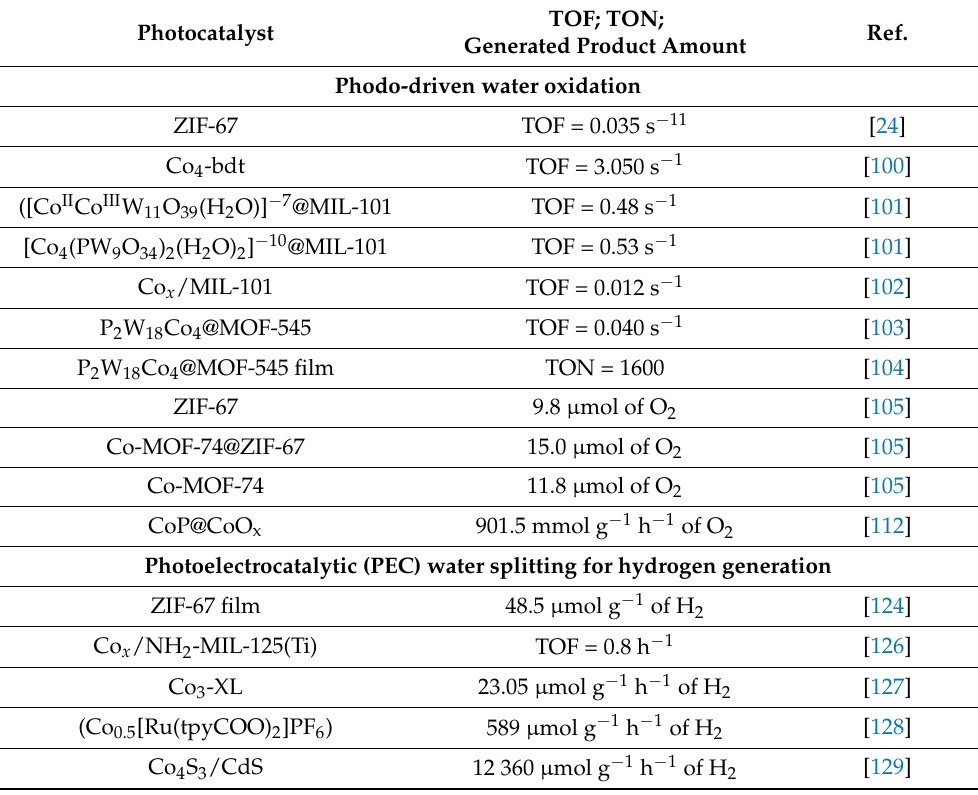
Table 2. Examples of Co-based MOFs, MOFs composites and MOF-derived materials used in the photo-driven water oxidation (PWO) for oxygen evolution and photoelectrocatalytic (PEC) water splitting for hydrogen